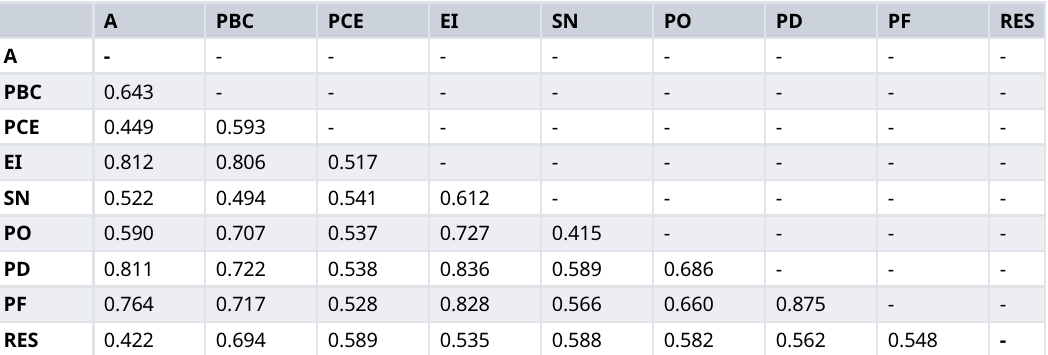
Table 2. Discriminant validity criteria: Heterotrait-Monotrait ratio